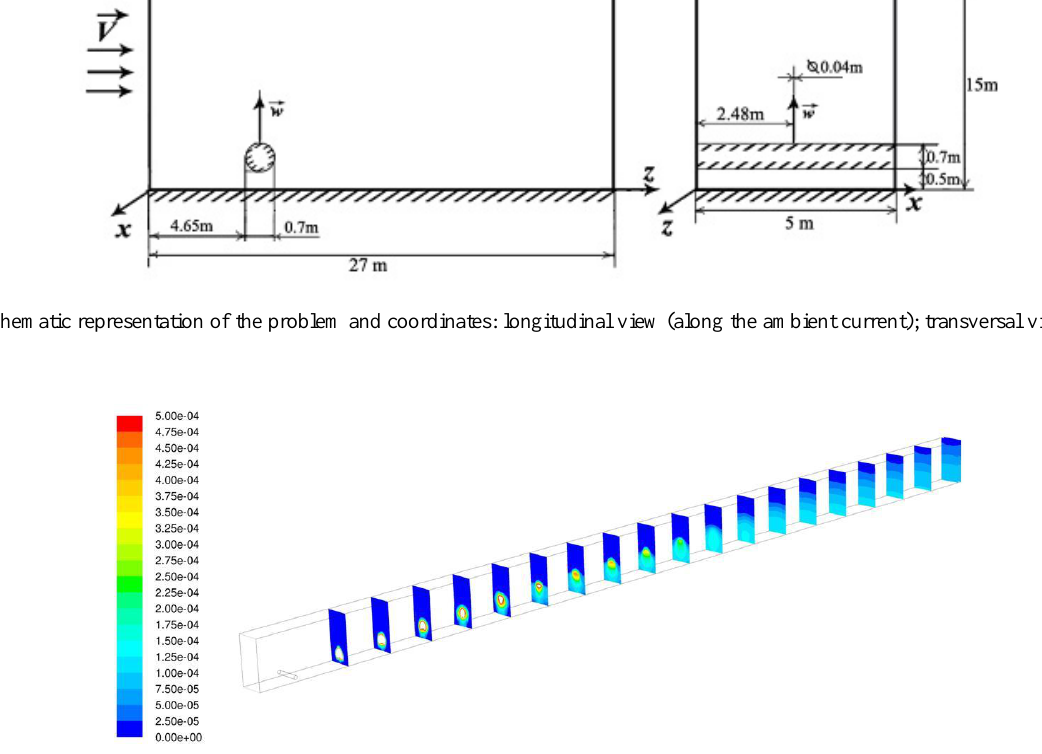
Fig. 3. Concentration fields in vertical cross sections perpendicular to the ambient current at different distances from the diffuser: 20, 30, 40, ..., 200m. Ambient current velocity V = 0 . 55ms − 1 . The unit of concentration is wt